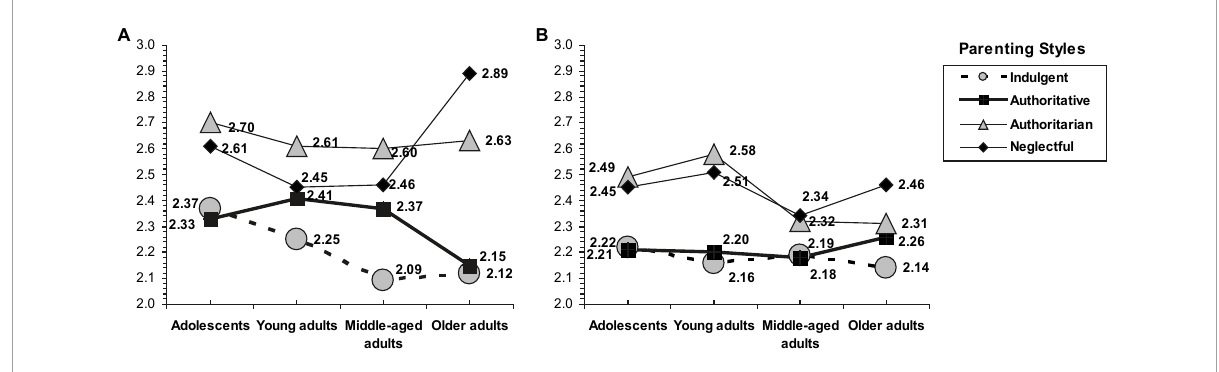
FIGURE2 Interaction of parenting styles by age group and sex on emotional vulnerability. (A) Emotional vulnerability (women). (B) Emotional vulnerability (men).